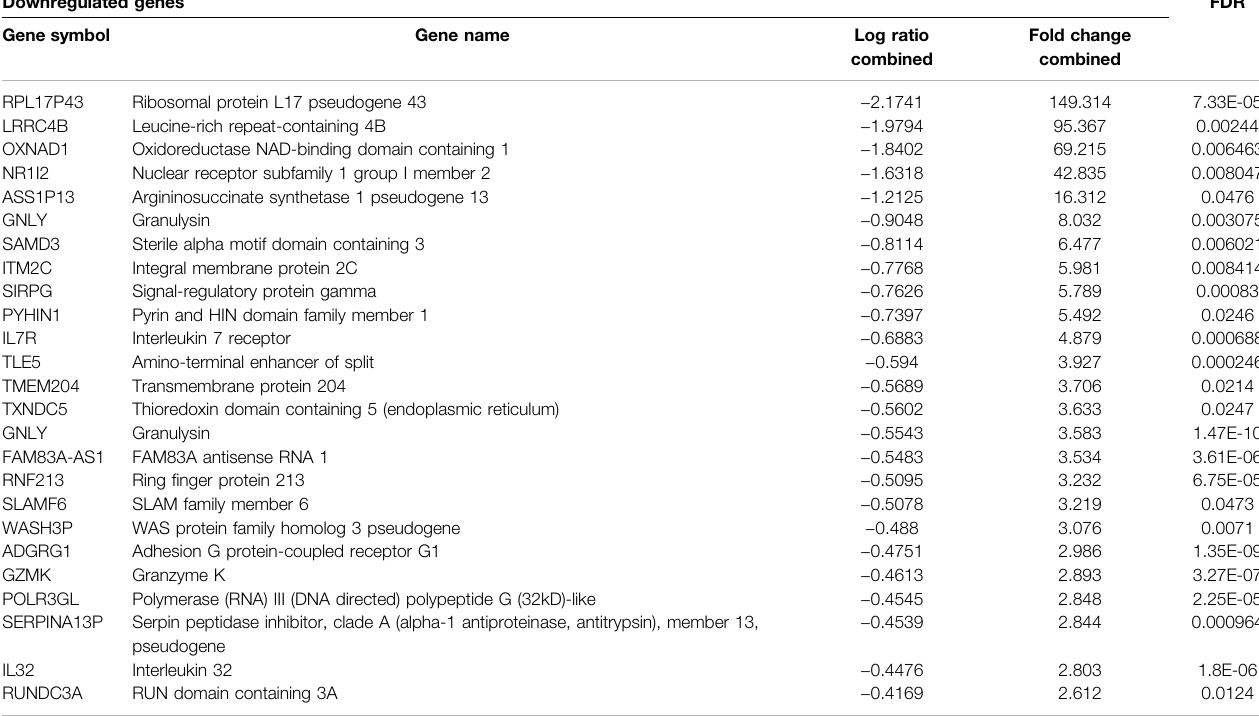
TABLE 4 | Top 25 downregulated genes of the microarray meta-analyses along with their fold change values. Downregulated